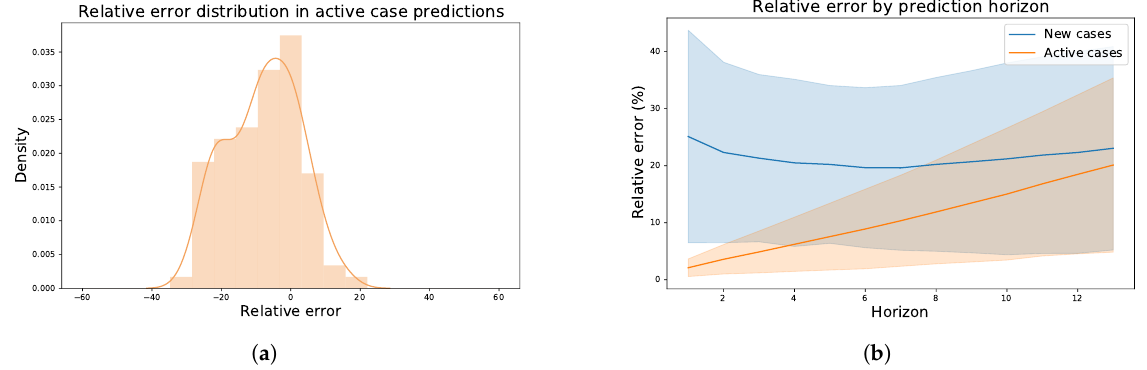
Figure 8. Analysis of the error distribution in the prediction of infected individuals. ( a ) Distribution of the relative error for a 7-day prediction horizon. ( b ) Error as a function of the prediction horizon. Solid lines depict the mean of the absolute value of the relative error, while the shaded regions depict its sample standard